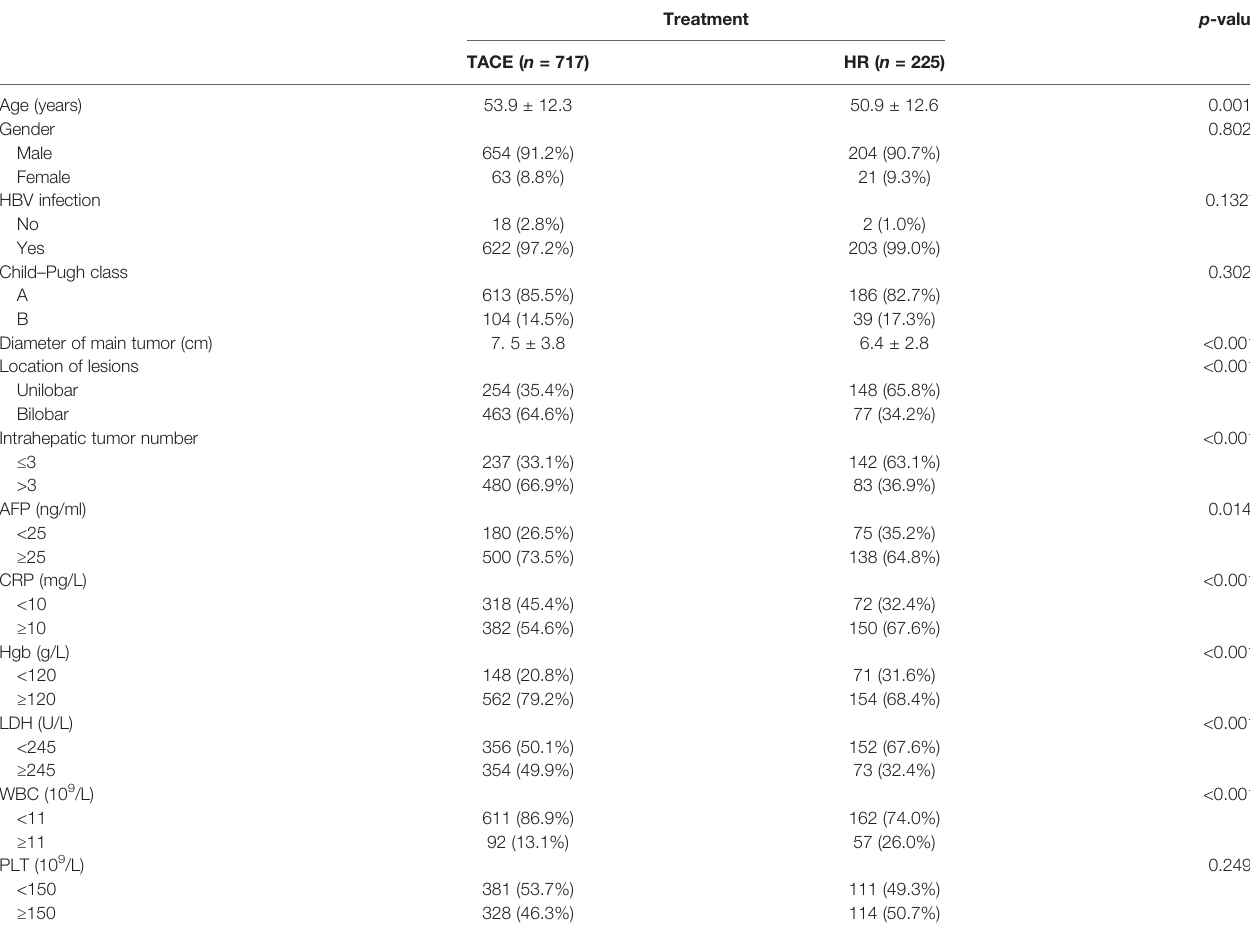
TABLE 1 | Baseline characteristics between the transarterial chemoembolization (TACE) and hepatic resection (HR) groups in the derivation